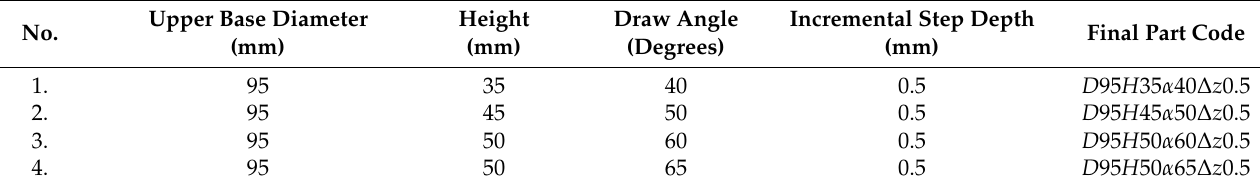
Table 1. Frustum-of-cone part configurations.